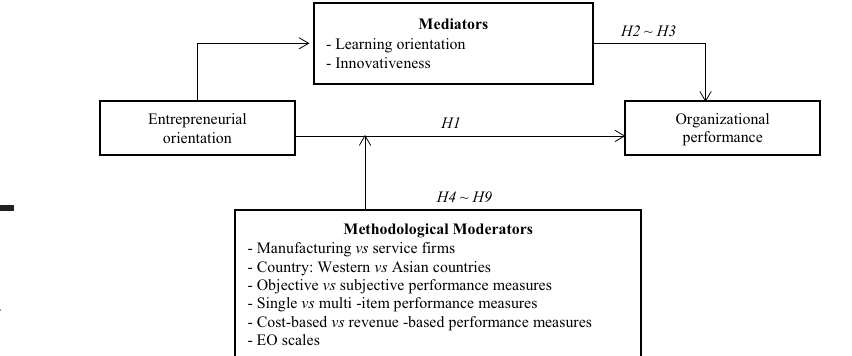
Figure 1. Conceptual framework for